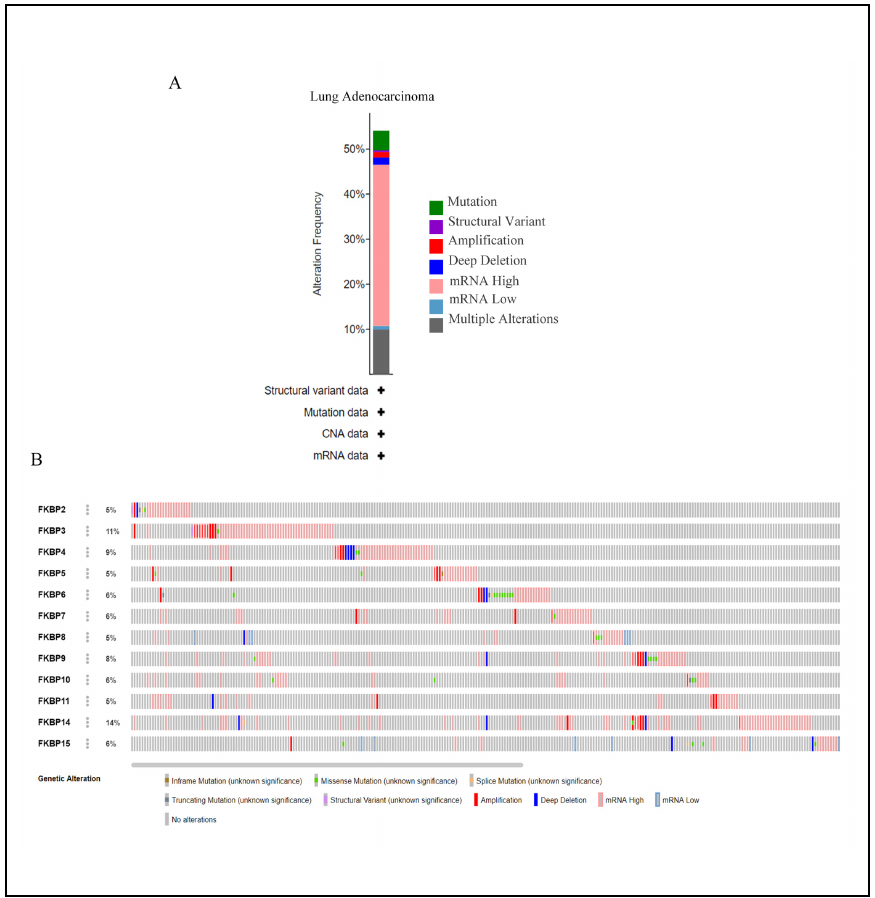
Figure 4. Analysis of genetic alterations of FKBP family numbers in lung adenocarcinoma (LUAD) samples using the CBioPortal database. (A) Summary of genetic alterations in dis ‐ tinctive FKBP gene family members in LUAD. (B) OncoPrint dataset showing the FKBP fam ‐ ily numbers showing alterations of individual FKBPs on queried genes. The horizontal axis represents each LUAD patient from the TCGA database, and the rate of genetic alterations in FKBP family members ranged from 5% to 14%. 3.1. Survival Analysis and Prognostic Values of FKBP Family Members in LUAD To assess associations between distinct transcriptional levels of FKBP family members and survival rates of LUAD, we used the KM plotter database, and pref ‐ erentially analyzed OS (Figure 2). Outcomes revealed that five members of the FKBP gene family had correlations with poor prognoses among LUAD patients in the OS analysis including FKBP3 ( p =0.0034; hazard ratio (HR)=1.55), FKBP4 ( p =0.00051;